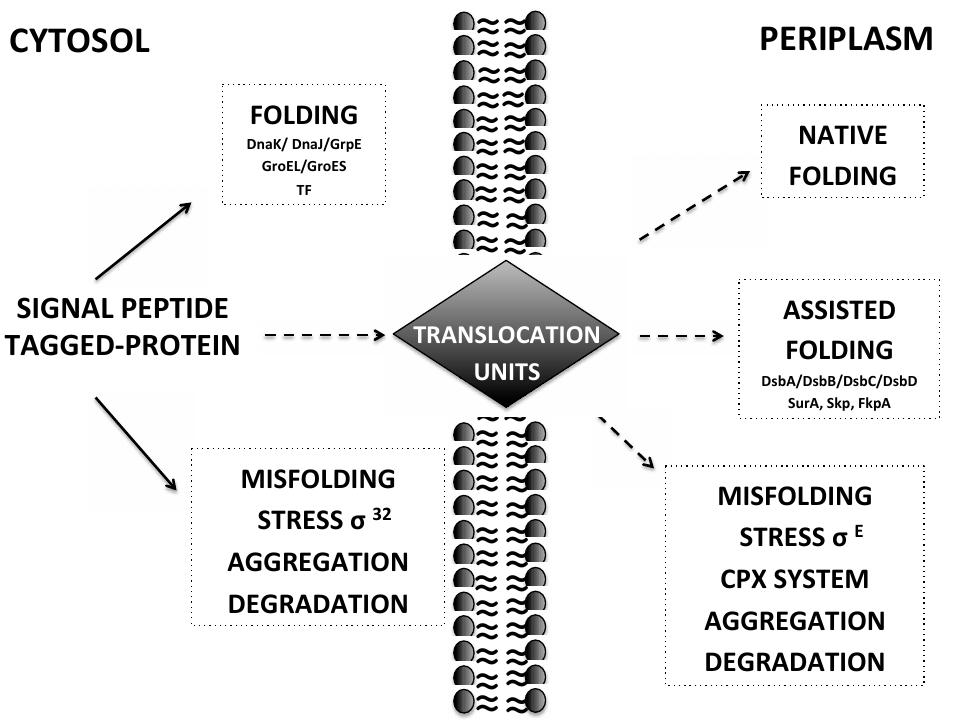
Figure 1. Schematic representation of optional folding and misfolding pathways for periplasmic recombinant protein.